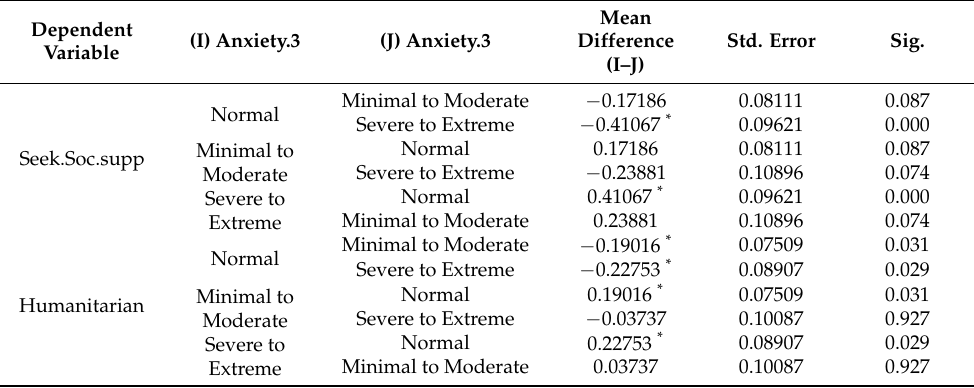
Table 4. Multiple Comparisons Tukey HSD.